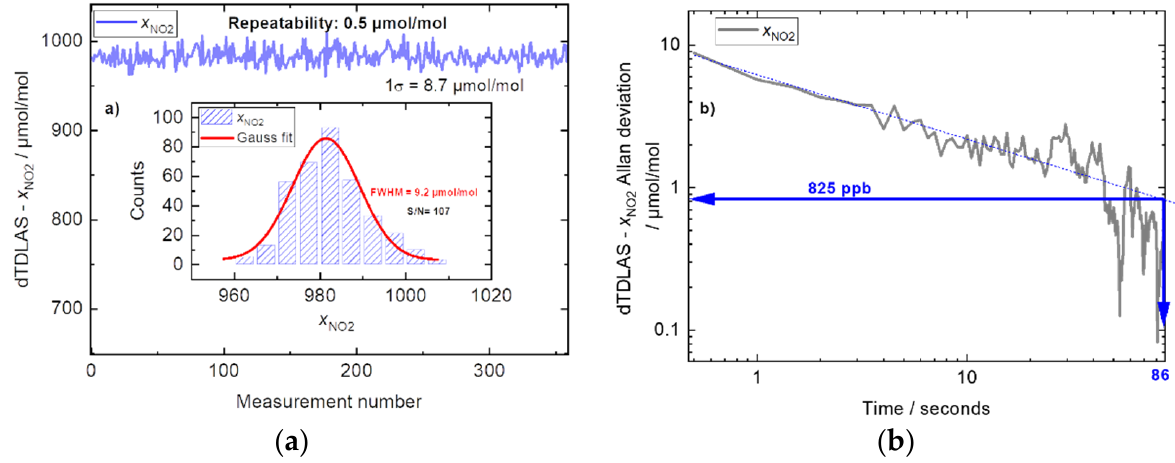
Figure 3. ( a ) Repeated NO 2 measurements: plot of NO 2 OGS amount fraction results vs. measurement number; ( b ) Allan deviation: plot of the x NO2 Allan deviation as a function of time.